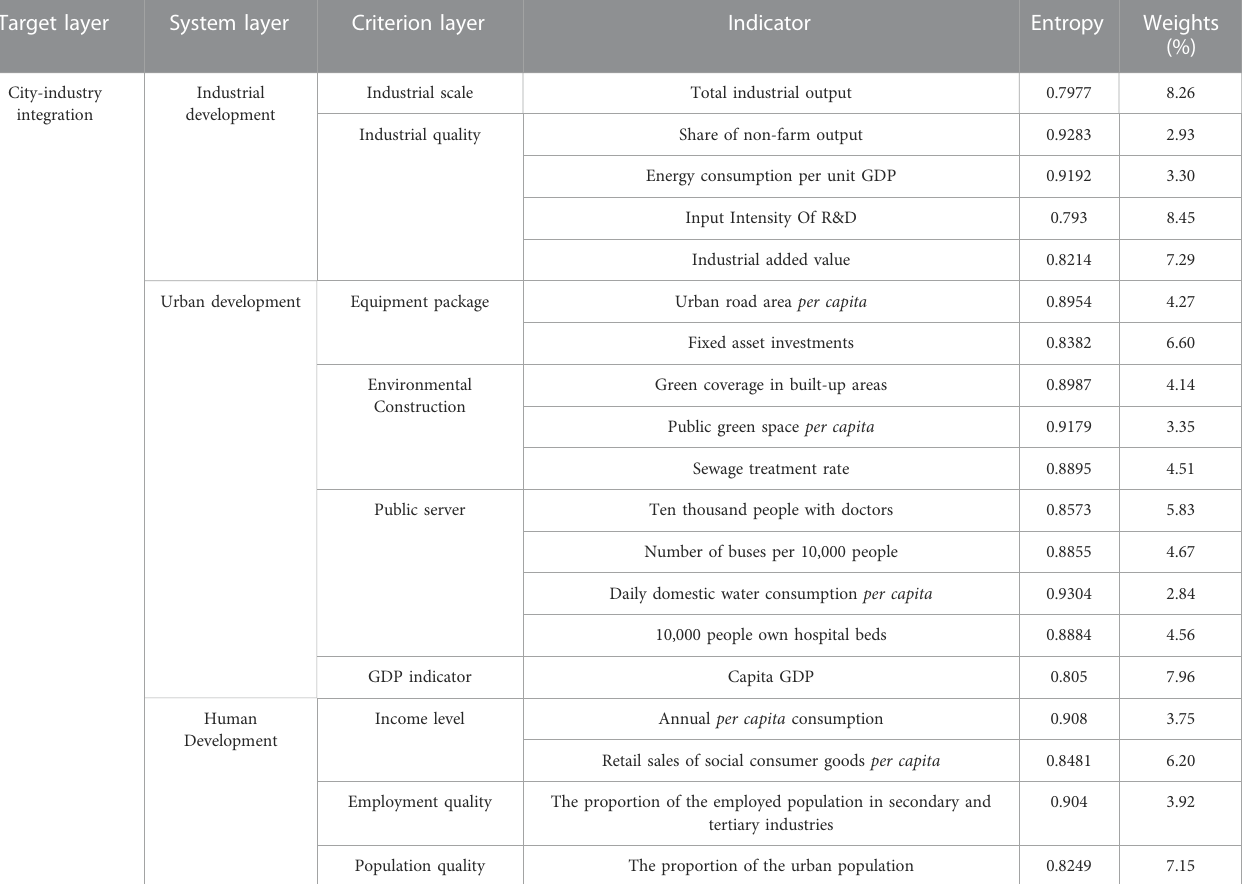
TABLE 1 Evaluation indicators of city-industry integration and their entropy and weight